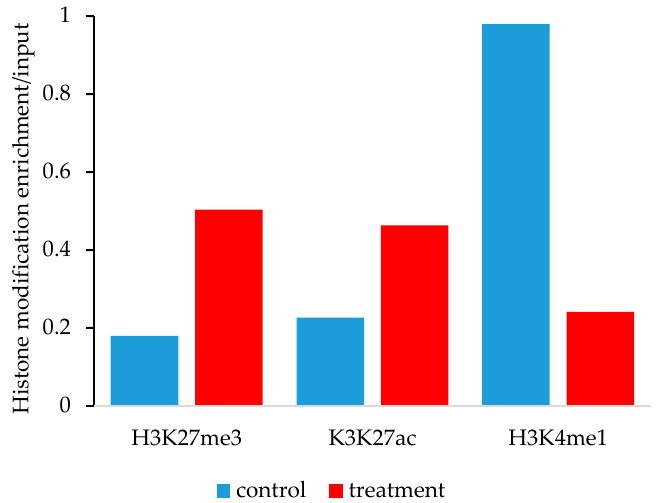
Figure A2. Weight changes in mice during the 11 days of YM155 treatment or control. No observable differences were seen for any individual mouse or between treatment groups.